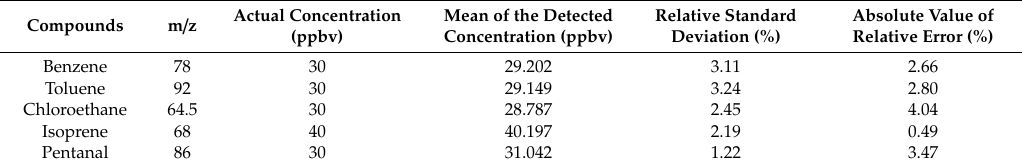
Table 1. The repeatability and relative error of each target